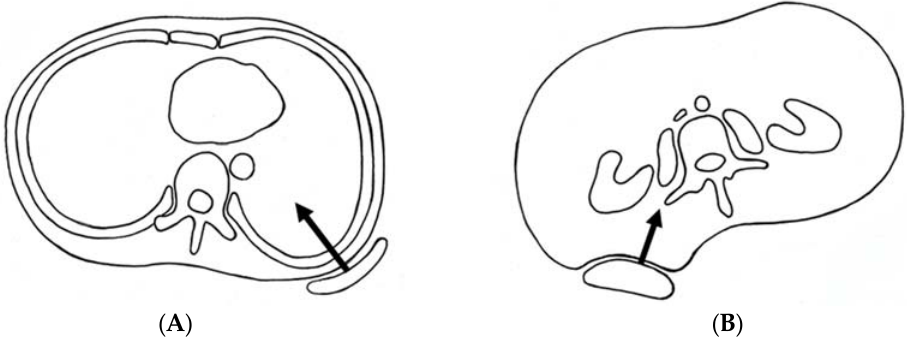
Figure 3. Optimal position of pads to add proper mechanical forces. ( A ) Thoracic spine; ( B ) lumbar spine.